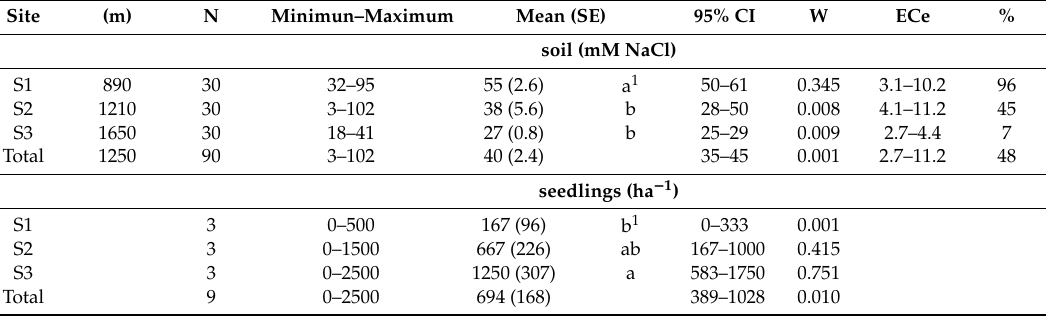
Table 1. Descriptive statistics for soil salinity (0–20 cm) and number of Fraxinus angustifolia seedlings in “Lame di fuori“ sampling sites (S1–S3). Distance from seaside (m); N = number of samples (soil) or transects (seedlings). W = p -value for Shapiro–Wilk normality test. ECe (electrical conductivity of soil saturation extract) = soil ECEe min–max range in dS / m. % = fraction (in percent) on the total of saline (ECe ≥ 4 dS / m) soil